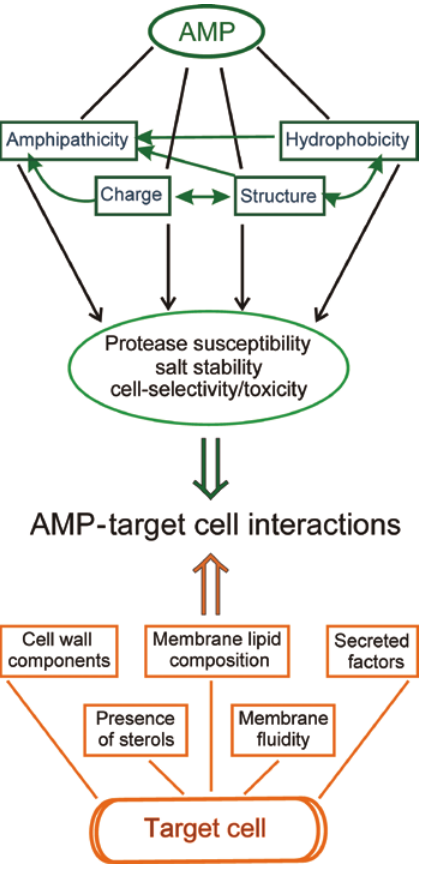
Figure 2: Scheme summarizing complex interactions between a defense peptide and a target